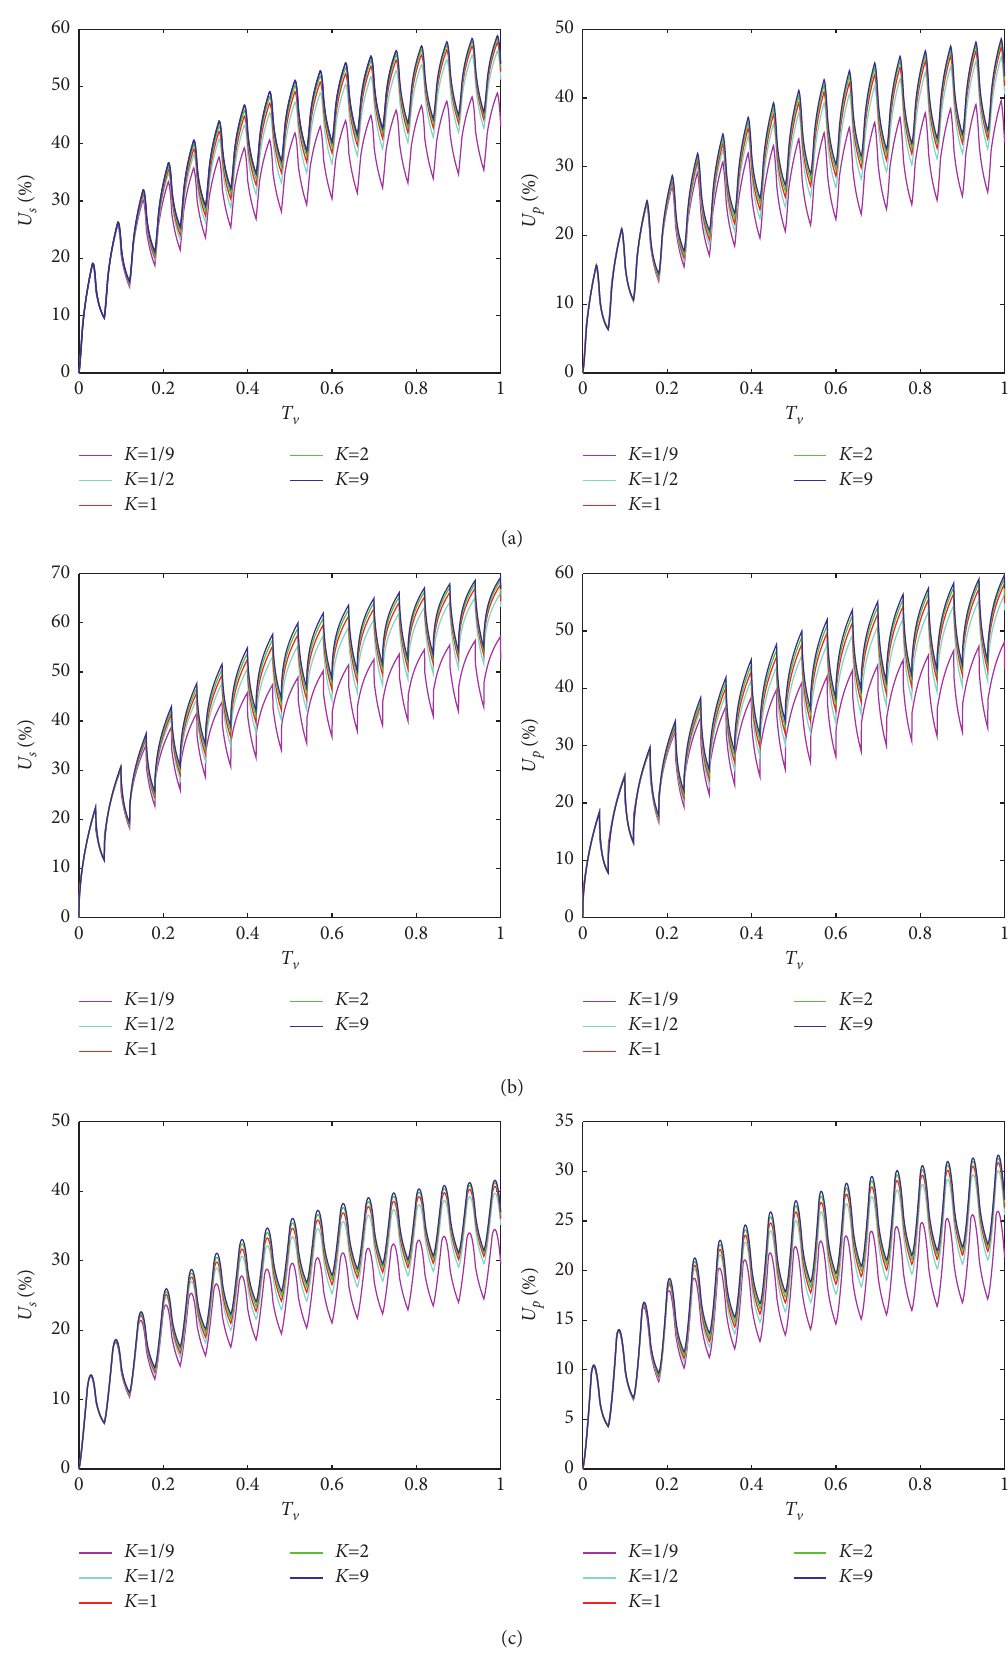
Figure 7: The variations of average degrees of consolidation U